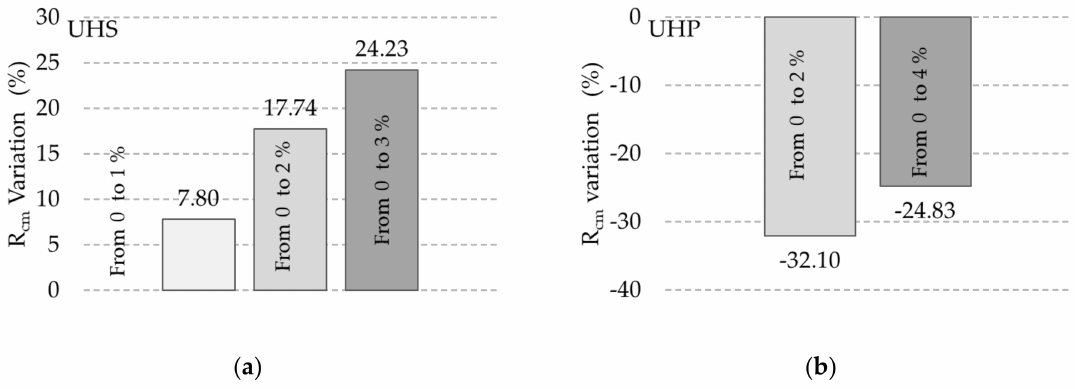
Figure 1. Mean cube compressive strength variation increasing the fiber volume fraction: ( a ) concrete reinforced with steel fibers (UHS) and ( b ) concrete reinforced with polymer fibers (UHP) after seven days of